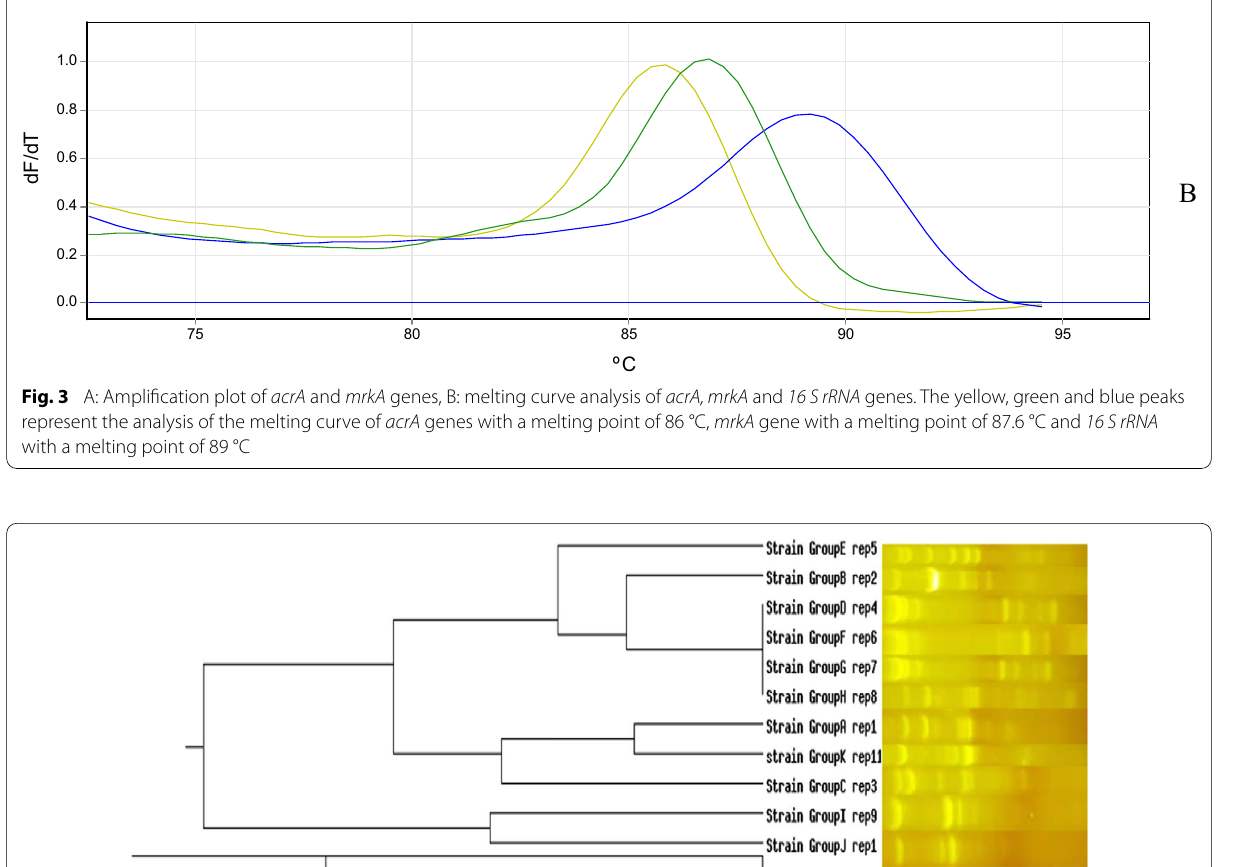
Fig. 4 The rep-PCR of representative K. pneumoniae strains using the UPGMA based on Dice similarity. Showed 11